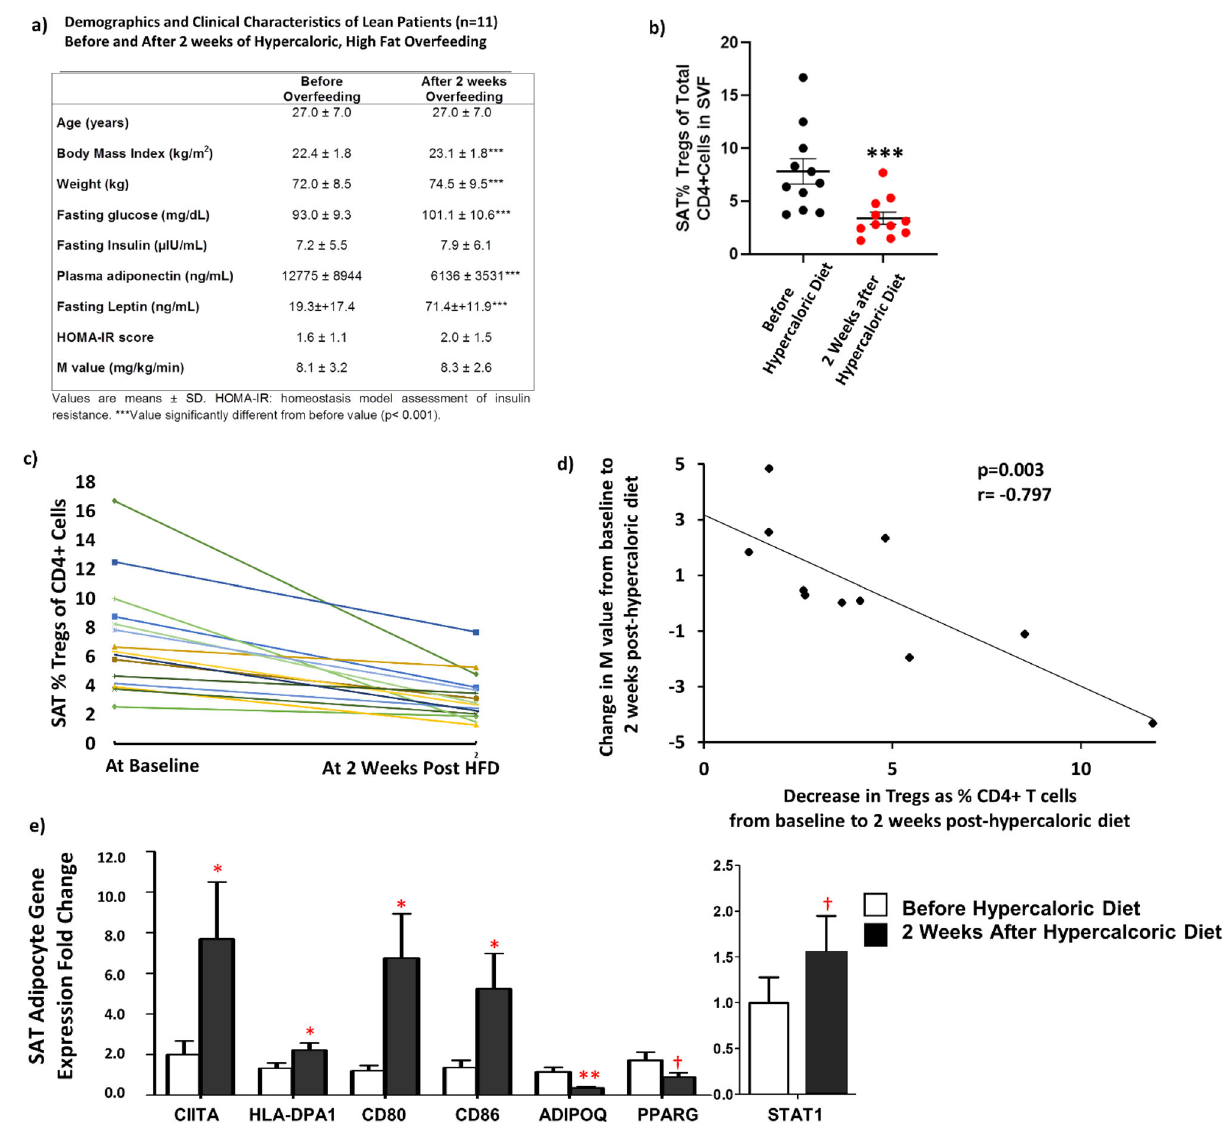
Fig. 3 | SAT Tregs decrease acutely following a hypercaloric, high-fat diet and are related to adipocyte MHCII gene expression and insulin resistance. a Clinical Characteristics of lean subjects ( N =11) before and after 2 weeks of a hypercaloric, high saturated fat diet (HFD). Change in SAT Tregs as % of total CD4+cellsin the stromal vascular fraction (SVF)from beforeto after 2 weeks HFD ( N =11) by Wilcoxon signed ranks test ( b ) as a group and ( c ) in each individual participant. d Correlation (Spearman) between the change in M value ( N =11) and decrease in SAT Tregs as percent (%) of total CD4+cells in the SVF from before to